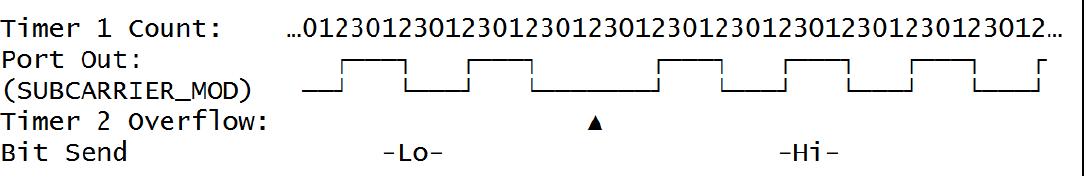
Figure 4. Timer counting scheme: SUBCARRIER_MODULATION is toggled by timer 1. On timer 2 overflow, the toggling scheme is inverted or not, depending on the data to be transmitted. This generates the BPSK signal.